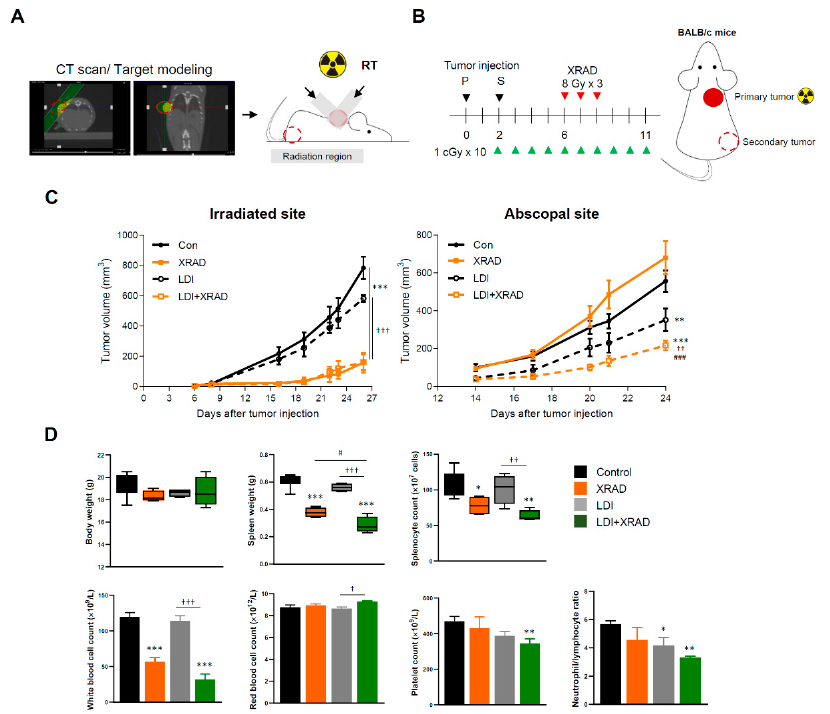
Figure 3. LDI enhances the abscopal effect combined with high-dose RT. ( A ) Schematic representation of the X-RAD SmART (small animal image-guided radiation therapy research system; Precision X-ray Inc., North Branford, CT, USA) irradiator setup. Acquiring cone beam computed tomography (CBCT) scans to precisely place the isocenter to the treatment location and visualize the internal structure of mice. X-RAD SmART Plan to calculate dose, provides complex beam planning. ( B ) Experimental scheme of tumor inoculation and irradiation interval to mice as described in the Methods section. ( C ) Tumor growth was monitored with irradiated and abscopal tumors in each group. ( D ) Body and spleen weight were measured at the end of the experiment. Splenocyte number was determined using a Trypan blue exclusion assay. Whole blood was drawn by retro-orbital puncture and analyzed using a VETSCAN HM5 hematology analyzer (Abaxis, Union City, CA, USA). Data represent means ± SEM of 6-8 mice per experiment. * p < 0.05, ** p < 0.01, *** p < 0.001 vs. control, † p < 0.05, †† p <